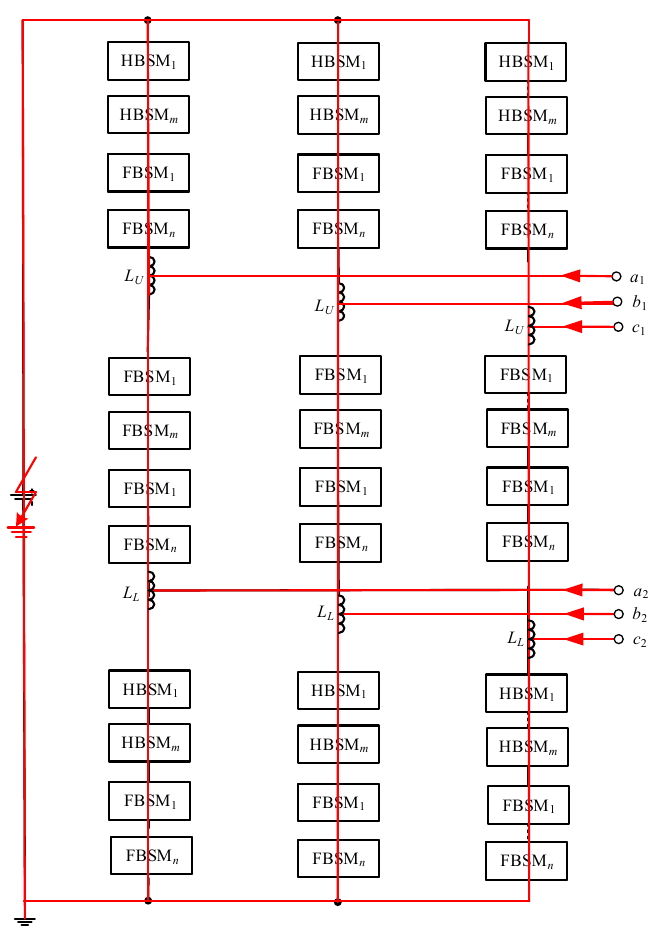
Figure 6. The possible fault current paths of the hybrid nine-arm high-voltage inverte r .